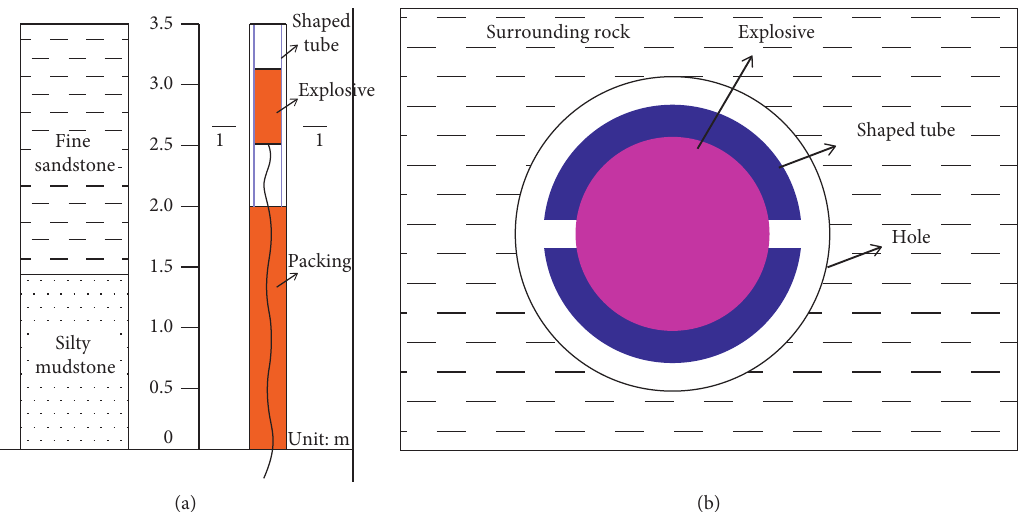
Figure 18: Illustration of single hole charge. (a) Loaded constitution. (b) 1-1 prefile.